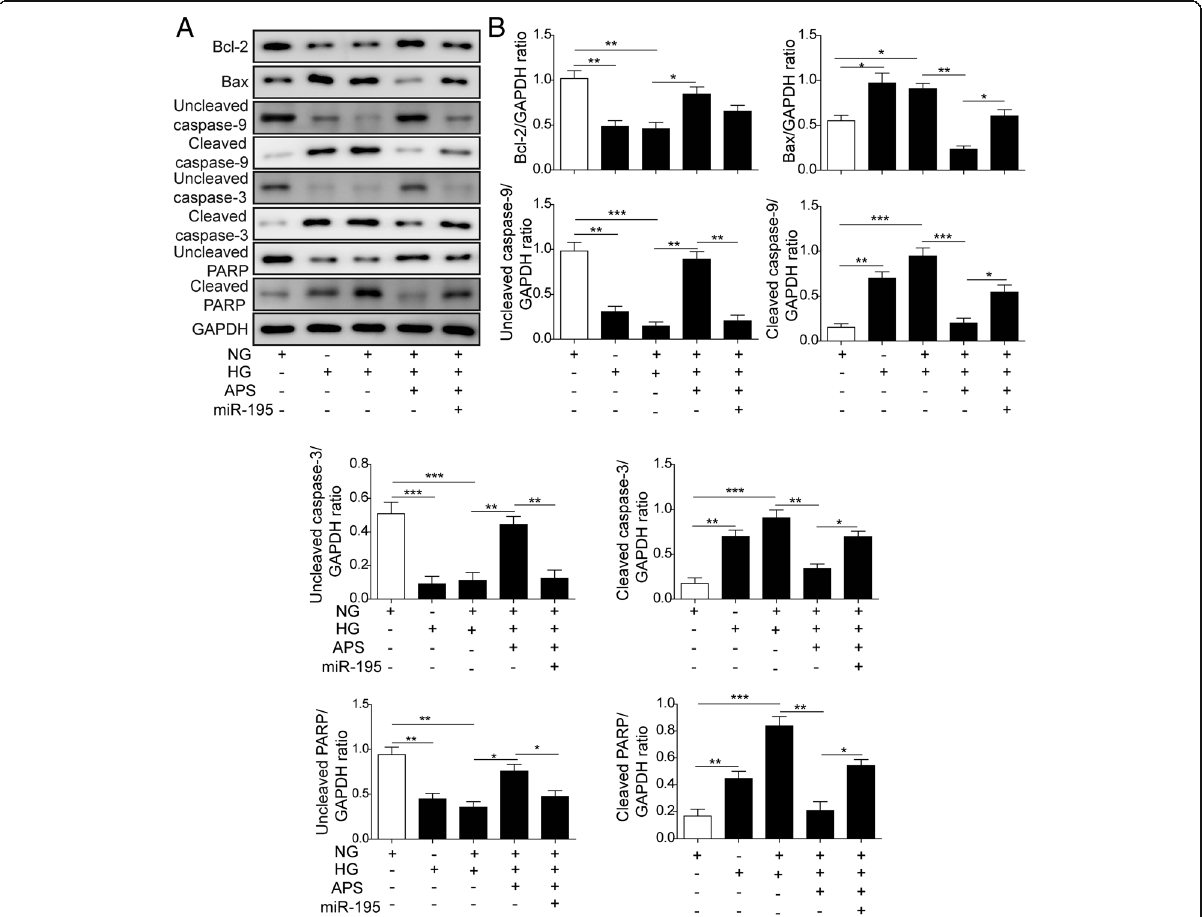
Fig. 9 MiR-195 activated mitochondrial apoptotic pathway in ARPE-19 cells. a Western blotting showed miR-195 mimics significantly increased the expressions of Bax, cleaved caspase-9, cleaved caspase-3 and cleaved PARP while decreased the expressions of Bcl-2 and uncleaved form of caspase-9, caspase-3 and PARP compared to the APS treated ARPE-19 cells. b The statistical results of western blotting in A. Error bars represented mean ± SD. *** p < 0.001, ** p < 0.01, * p <